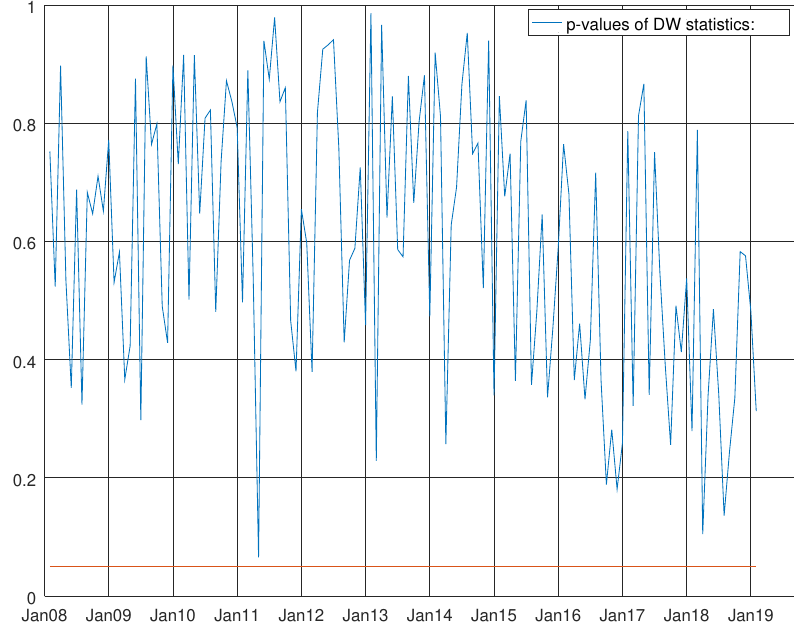
Figure 25. Graph shows the p -values of the Durbin–Watson test for the enhanced model for non-durable goods. The null hypothesis states that residuals are not